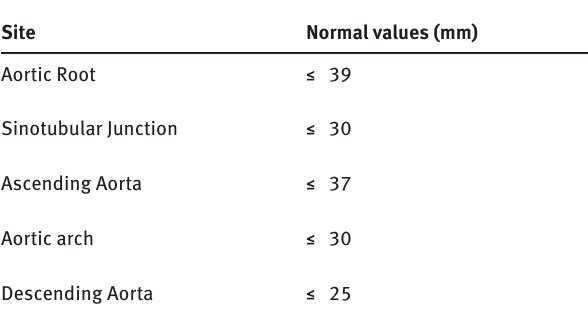
Table 1: In the table are reported the normal values of the thoracic